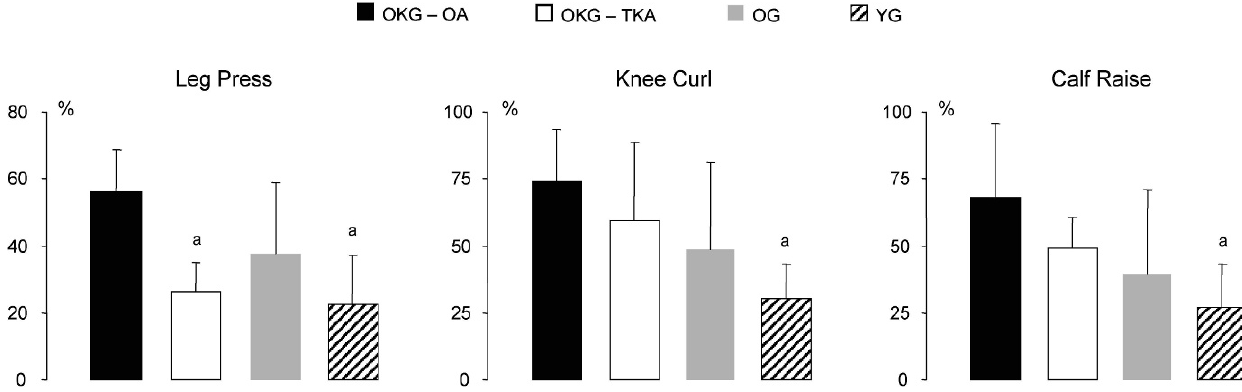
Figure 1 - Muscle strength (1-RM test) increase after 13 weeks of resistance training. OKG: Older knee osteoarthritis and total knee arthroplasty group. OG: Older control group. YG: Young control group. OA: Lower limb with knee osteoarthritis. TKA: lower limb with total knee arthroplasty. a denotes significant difference between TKA and OA legs ( p , 0.05).